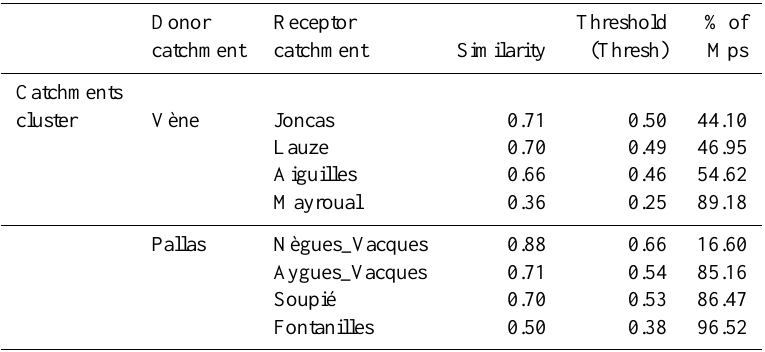
Table 4. Results of catchment clustering and number of Mps transferred from the donor to the receptor catchment based on the similarity measure. Donor